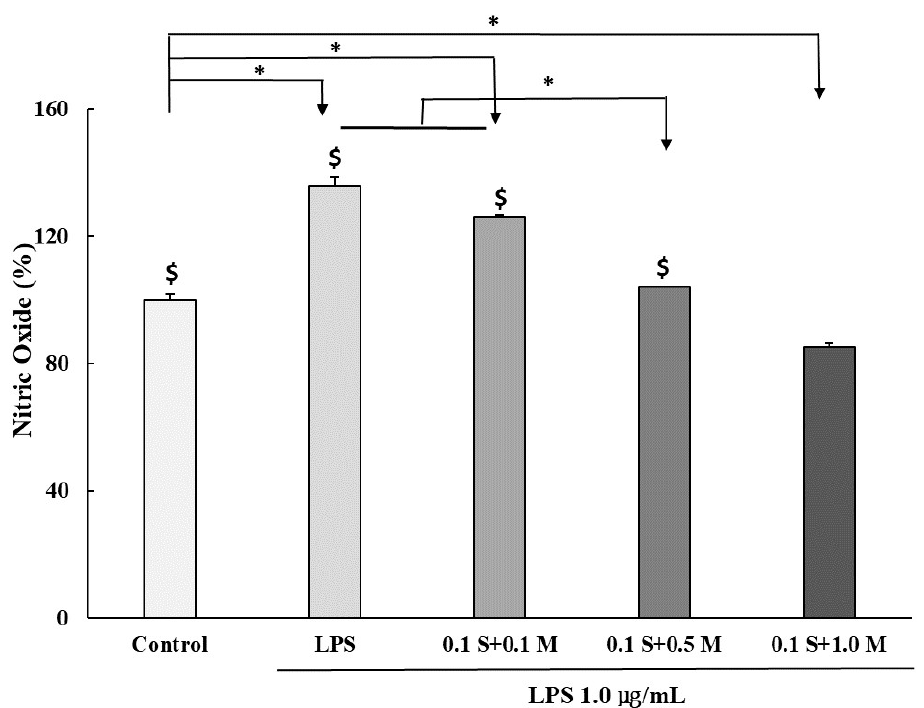
Figure 3. NO assay based on the ratio of the sericin and MSM blends using Raw 264.7 macrophage. Cell treated with 1.0 (0.1S + 0.1M), 5.0 (0.1S + 0.5M), and 10.0 (0.1S + 1.0M) mg/mL MSM at 1.0 mg/mL sericin, stimulated with 1 µ g/mL LPS. All values are presented as the mean ± standard deviation (n = 3). * p < 0.05. $ p < 0.05 vs. 0.1S + 1.0M.